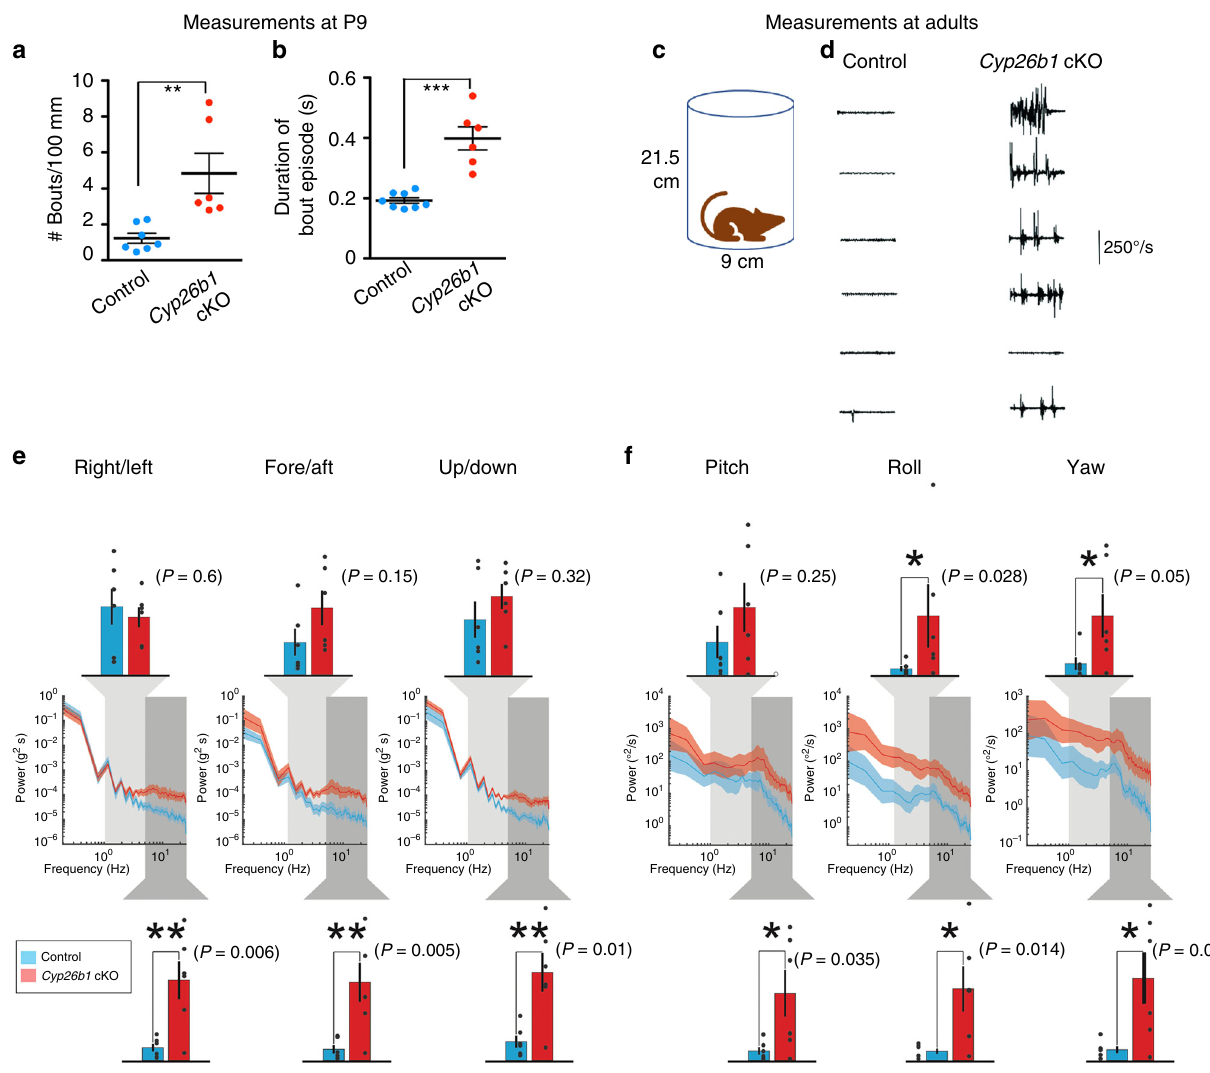
Fig. 9 Increased head tremor in Cyp26b1 cKO mice. a , b Quanti fi cation of head tremor for P9 pups. The number of bouts normalized over a 100 mm distance traveled ( a ) and average duration of each head-tremor episode over a 10-min period are shown ( b ). Cyp26b1 cKO pups showed more frequent ( a , 4.8 ± 1.1 in mutants, n = 6, vs. 1.2 ± 0.2 in controls, n = 8, P = 0.0059) and longer duration ( b , 398 ± 38 ms in mutants vs. 192 ± 9 ms in controls, n = 8, P < 0.0001) head tremor, compared to Foxg1 Cre ;Cyp26b1 lox/ + controls. c Schematic of the apparatus for measuring head tremor of an adult mouse at rest with a miniture head motion sensor af fi xed on the top of the skull. d Cyp26b1 cKO showed characteristic head tremor (5/6), which were not present in controls. e , f Comparison of power spectra density of head movements in translational axes ( e ) and rotational axes ( f ) between controls (blue) and Cyp26b1 cKO mutants (red). Cyp26b1 cKO exhibit sigini fi cantly higher power than controls at high frequencies (5 – 20 Hz, P = 0.006 for right/left, P = 0.005 for fore/aft, P = 0.01 for up/down, P = 0.035 for pitch, P = 0.014 for roll, and P = 0.011 for yaw axis, n = 6/group). Angular head velocity for yaw and roll axes of Cyp26b1 cKO also had signi fi cantly higher power for frequencies between 1 and 5 Hz (upper graphs, P = 0.05 for yaw and P = 0.028 for roll axis). Unpaired t test was applied for all panels. Error bars: SEM. * P < 0.05, ** P < 0.01, and *** P <